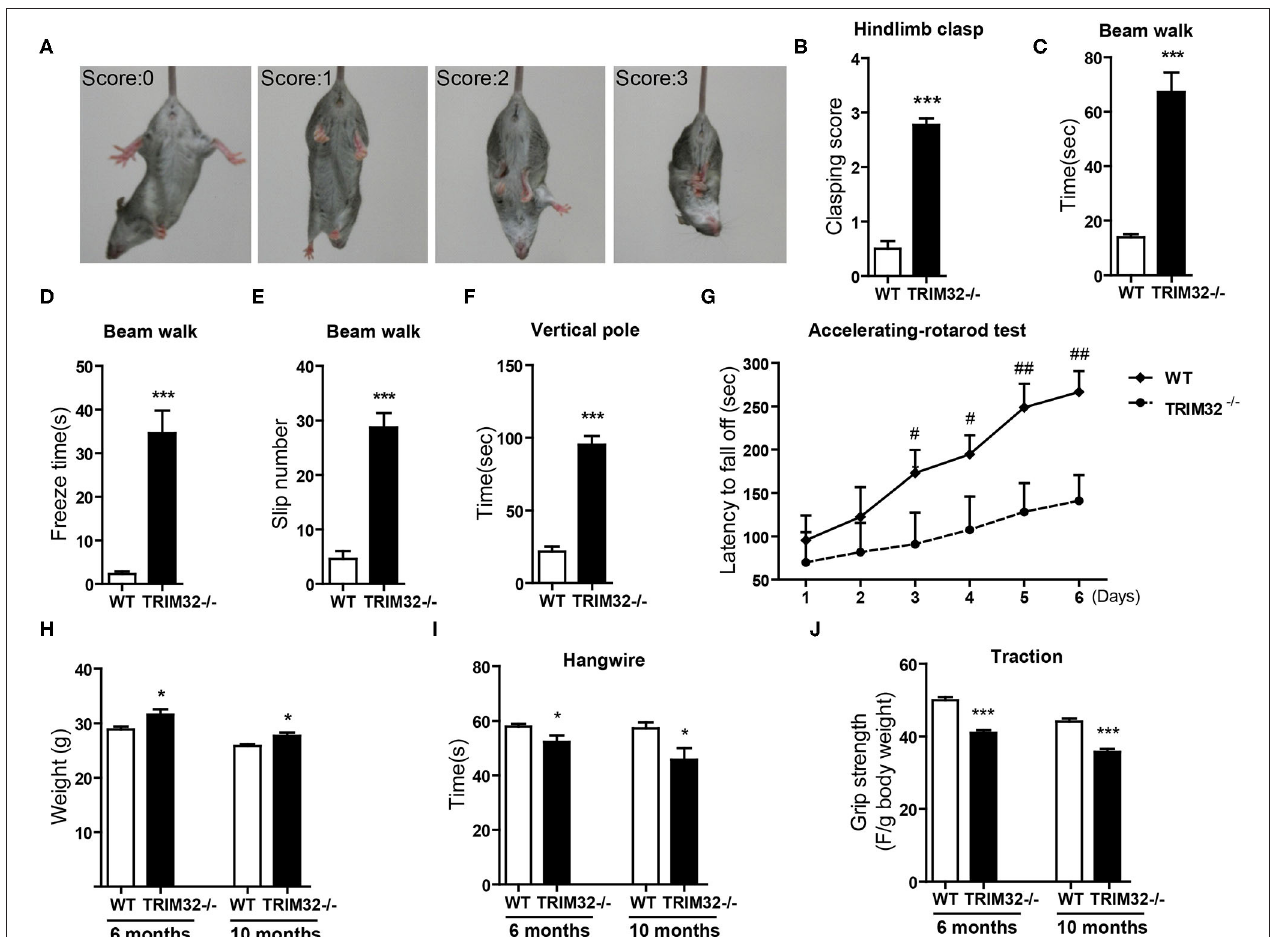
FIGURE 2 | TRIM32 deficiency impairs motor coordination and motor learning. (A) Scores assigned to representative postures in the hindlimb clasping test. (B) Hind-limb clasping of TRIM32 − / – and WT mice (aged, 10 months) was assessed. (C,D) Beam walk test. As compared with WT mice, the performance of TRIM32 − / – mice was poor in regard to the duration to cross the beam (C) , freeze time (D) , and the number of limb slips (E) while crossing the beam. (F) For the vertical pole test, the time to turn around and climb down was quantitated. As compared with control mice, the performance of TRIM32 − / – mice was significantly poorer. (G) Accelerating -rotarod performance was tested. The time TRIM32 − / – and WT mice remained on the rotarod before falling off was assessed. (H) The body of weight of TRIM32 − / – mice and the WT littermate controls were measured at ages of 6 and 10 months. (I) For the hangwire test, the latency to fall off by the TRIM32 − / – and WT mice were assessed at the ages of 6 and 10 months. TRIM32 − / – mice displayed impaired motor coordination and muscle deficits. (J) Muscular strength of TRIM32 − / – and WT mice at the ages of 6 and 10 months was evaluated using the traction test. TRIM32 − / – mice had weaker forelimb strength. Data are presented as mean ± SEM. n = 13 ( TRIM32 − / – mice), = 15 (WT mice). * p < 0.05, *** p < 0.001, # p < 0.008; ## p < 0.001. For the statistical analysis in G, t -test with Bonferroni correction was performed, p < 0.05/6 was considered statistically